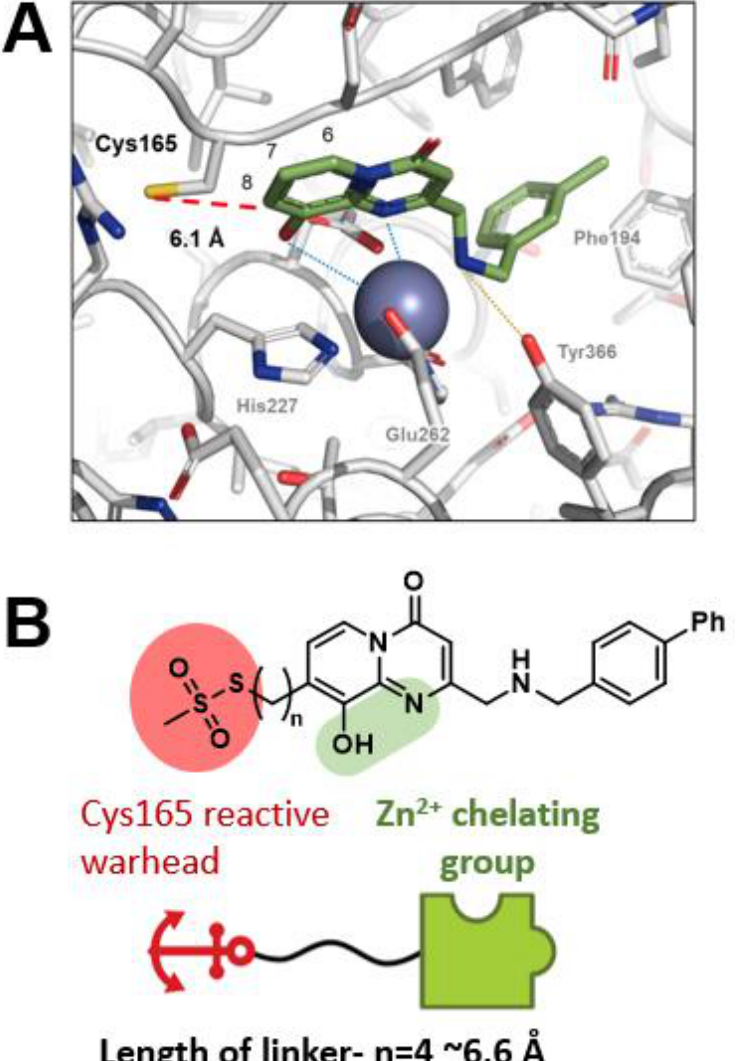
Figure 3. ( A ) Docking of compound 22 (green) at the active site of BoNT/A LC (PDB 4HEV). The dark gray sphere represents Zn 2+ . ( B ) Covalent linker design of “catch and anchor” inhibitor compounds 80 – 84 based on docking.